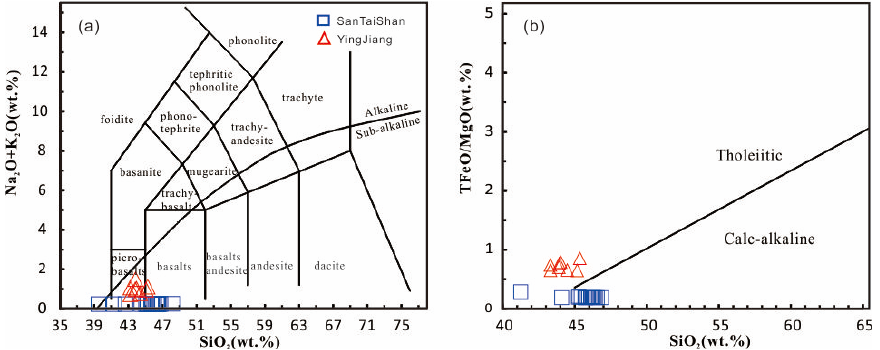
Figure 6. ( a ) SiO 2 –Na 2 O + K 2 O diagram (modified from [28]); ( b ) SiO 2 –TFeO/MgO diagram (modified from [29]).